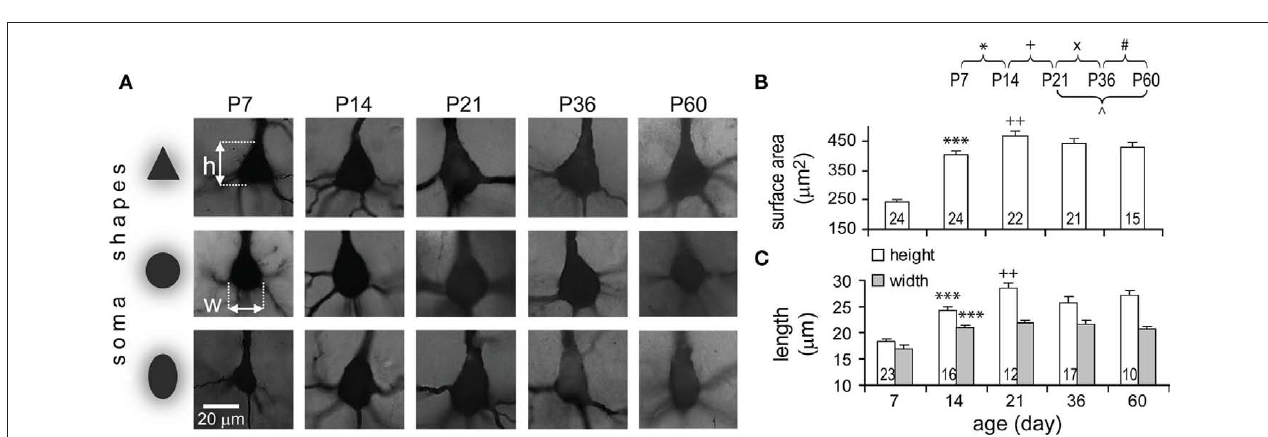
significantly increased. From P14 to P21, the height and surface area, but not the width, significantly increased. Same cells were used for height and width measures. Note, for this and subsequent figures, numbers in bars of column graphs indicate the numbers of analyzed cells and error bars are SEs.